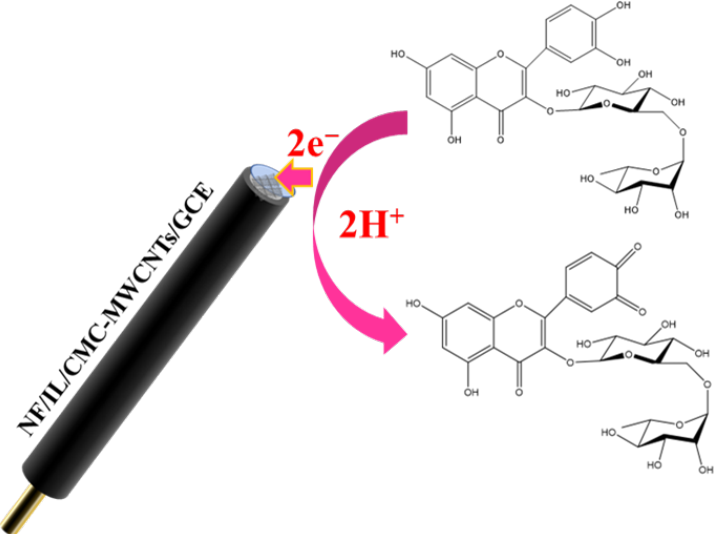
Scheme 1. The proposed mechanism of rutin reaction on an electrochemical sensor.